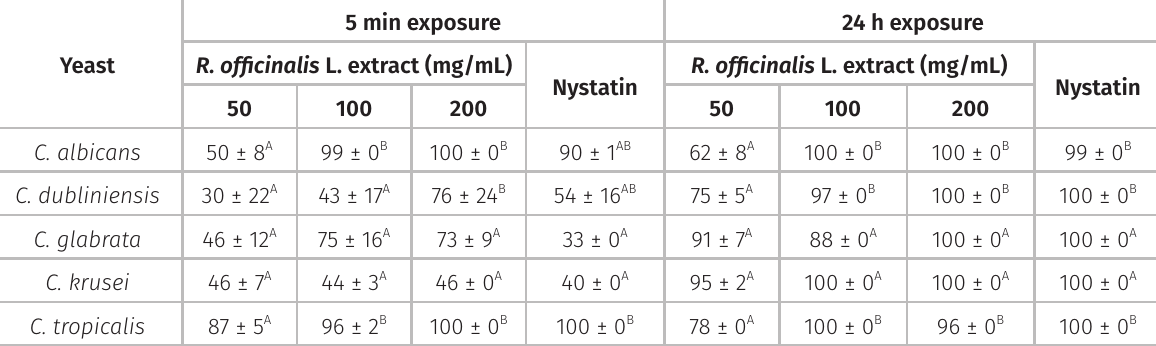
Table I. Reduction percentage of the fungal biofilms after exposure to the R. officinalis L. extract or